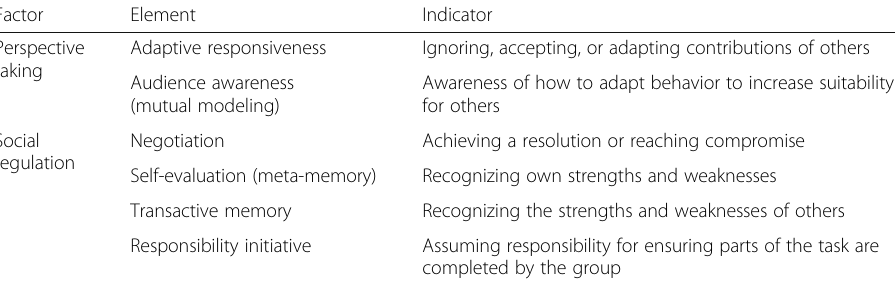
Awareness of how to adapt behavior to increase suitability for others